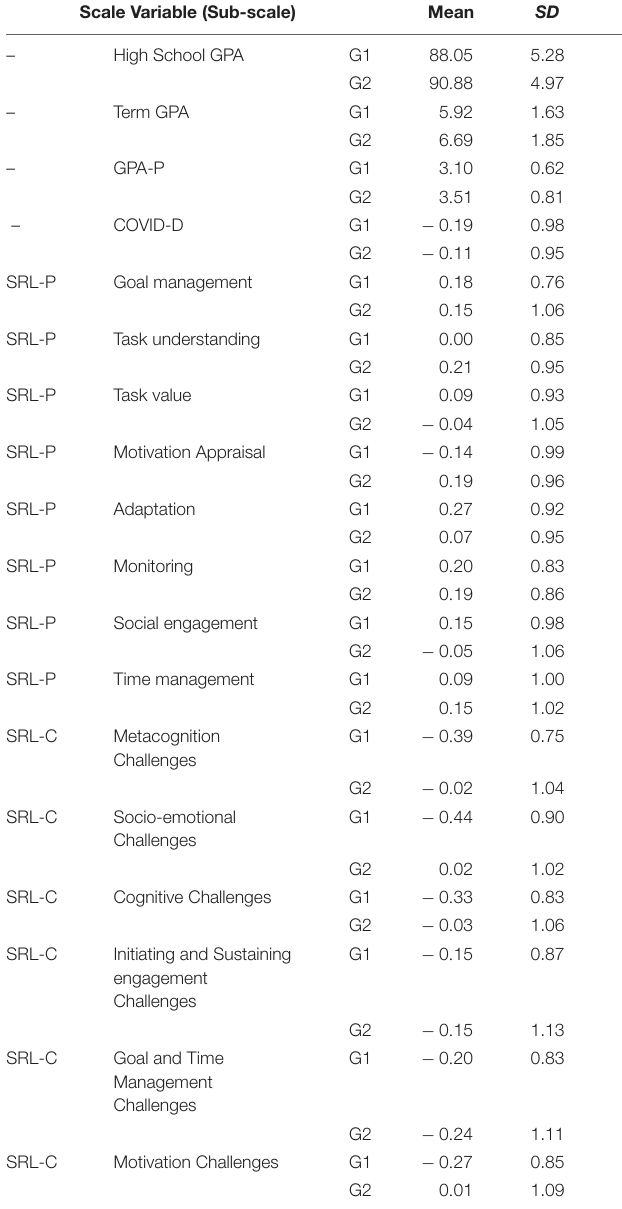
TABLE 4 | Descriptive statistics for the “first-year students” sub-sample (Model 2). have caused by heterogeneity of error variances across the two groups. However, research indicates that univariate group Scale Variable (Sub-scale) Mean SD analyses are robust to moderate violations of homogeneity of variances if group sample sizes are approximately equal (Nimon, 2012). This analyses revealed that after controlling for the effect of incoming GPA, students without SRL training had a significantly higher average adjusted mean for the SRL practice – motivation appraisal scale [Mean Difference = 0.33, t (154) =